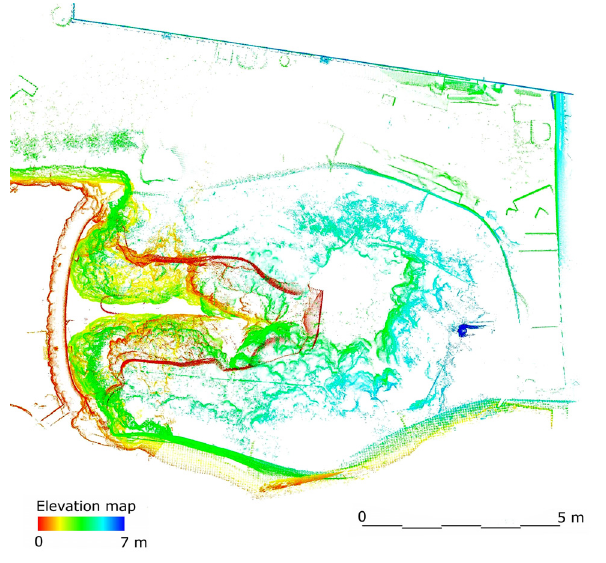
Figure 9. Elevation map